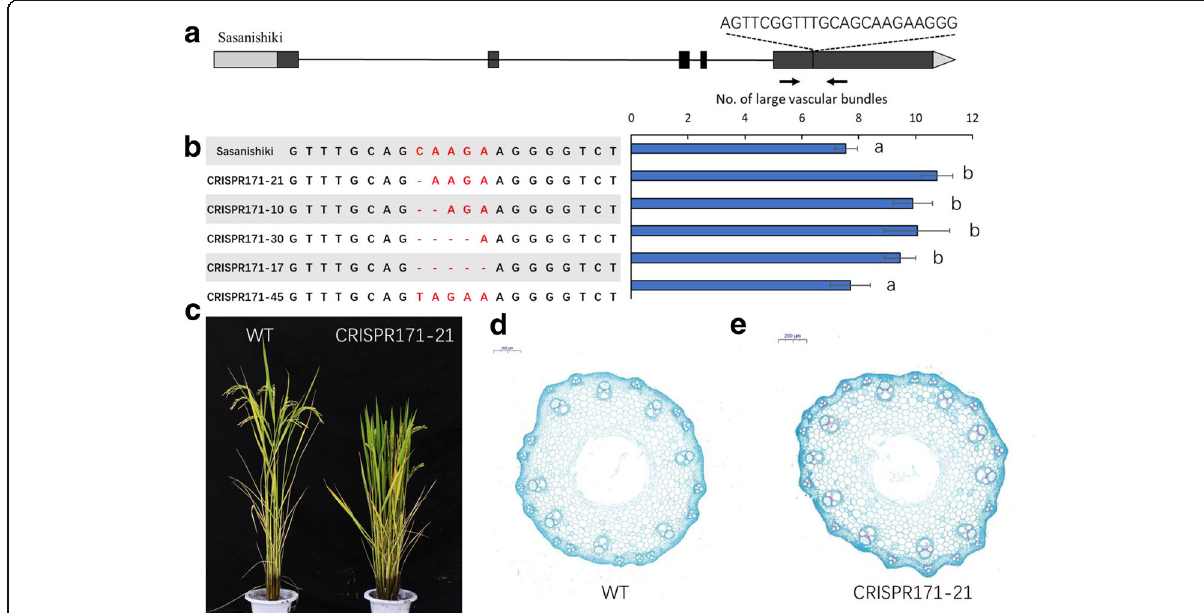
Fig. 4 The CRISPR/Cas9-induced DEP1 mutant lines and LVB investigation. a Schematic map of the genomic region of DEP1 and the sgRNA target site. Arrows show the position of the PCR primers used for mutation detection. b The sequence of the mutant lines and the number of LVBs of the mutant lines. c The WT plant and CRISPR/Cas9 induced DEP1 mutant line. d The difference in vascular bundles between WT plants and the CRISPR/Cas9 induced DEP1 mutant